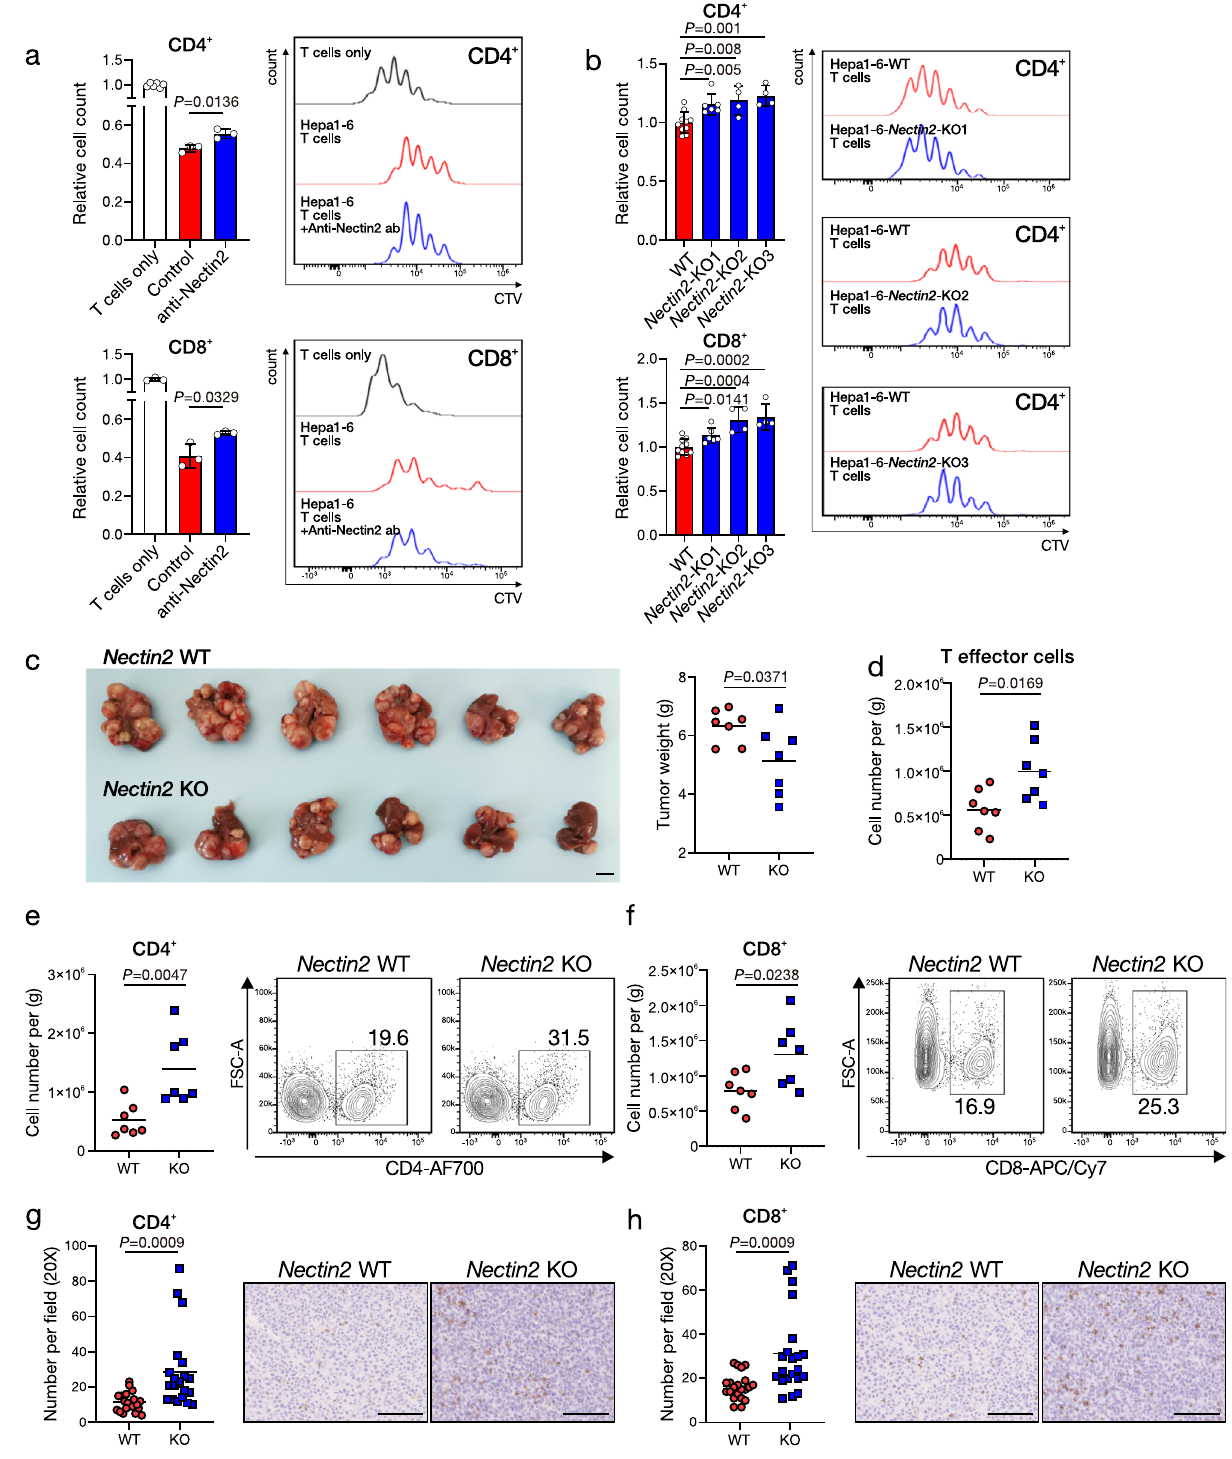
Fig. 5 NECTIN2 in HCC cells suppresses T cell activity. a CellTrace Violet (CTV)-labeled mouse splenic T cells were isolated and co-cultured with Hepa1 – 6 cells in the presence or absence of anti-Nectin2 neutralizing antibody (15 µ g/mL). Mean ± SD is presented. b CTV-labeled T cells were cocultured with Hepa1 – 6 (WT), - Nectin2 -KO1, - Nectin2 -KO2, - Nectin2 -KO3 cells. Mean± SD is presented. c Representative picture and weight of Nectin2 WT ( Nectin2 WT: Tp53 KO: c-Myc OE), and Nectin2 KO ( Nectin2 KO: Tp53 KO: c-Myc OE) HCC tumors. Scale bar = 1 cm. d – f Numbers of tumor-in fi ltrating lymphocytes were analyzed by fl ow cytometry. g , h Representative pictures, and quanti fi cation of CD4 + T cells and CD8 + T cells in HCC tumors by IHC staining. Scale bar = 100 μ m in IHC representative pictures. a – h Student ’ s t test. The experiment was performed with a variable number of biologically independent samples ( n number) ( a n = 6, n = 3, and n = 3 for T cells only Ctrl and anti-Nectin2 respectively in CD4 + cells, and n = 3 for all groups in CD8 + cells; b n = 10, n = 6, n = 4, and n = 4 for WT, Nectin2 -KO1, Nectin2 -KO2, and Nectin2 -KO3, respectively in both CD4 + and CD8 + cells; c – e , g : n = 7 per group; f , h : n = 21 per group). Source data are provided as a Source Data fi